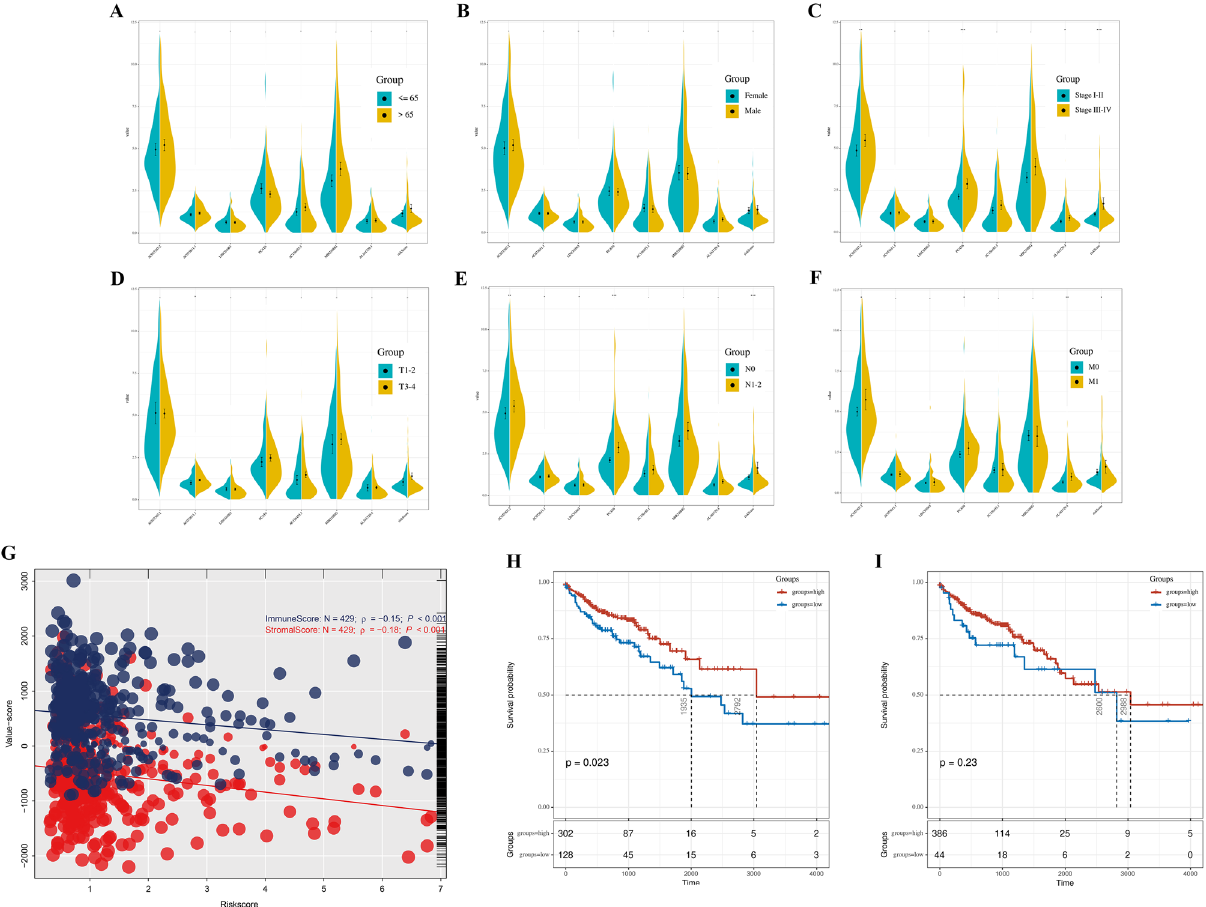
Figure 7. Clinical correlation and tumor microenvironment analysis. ( A ) The correlation of age with model lncRNAs and risk score; ( B ) The correlation of gender with model lncRNAs and risk score; ( C ) The correlation of clinical-stage with model lncRNAs and risk score; ( D ) The correlation of T classification with model lncRNAs and risk score; ( E ) The correlation of N classification with model lncRNAs and risk score; ( F ) The correlation of M classification with model lncRNAs and risk score; ( G ) The negative correlation of risk score with immune and stromal score. ( H ) Kaplan–Meier curve of the immune score in TCGA patients; ( I ) Kaplan–Meier curve of the stromal score in TCGA